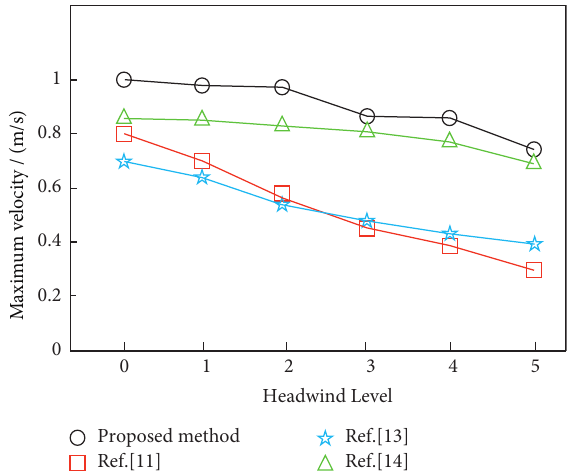
Figure 11: The relationship between the maximum velocity of different robots and the headwind